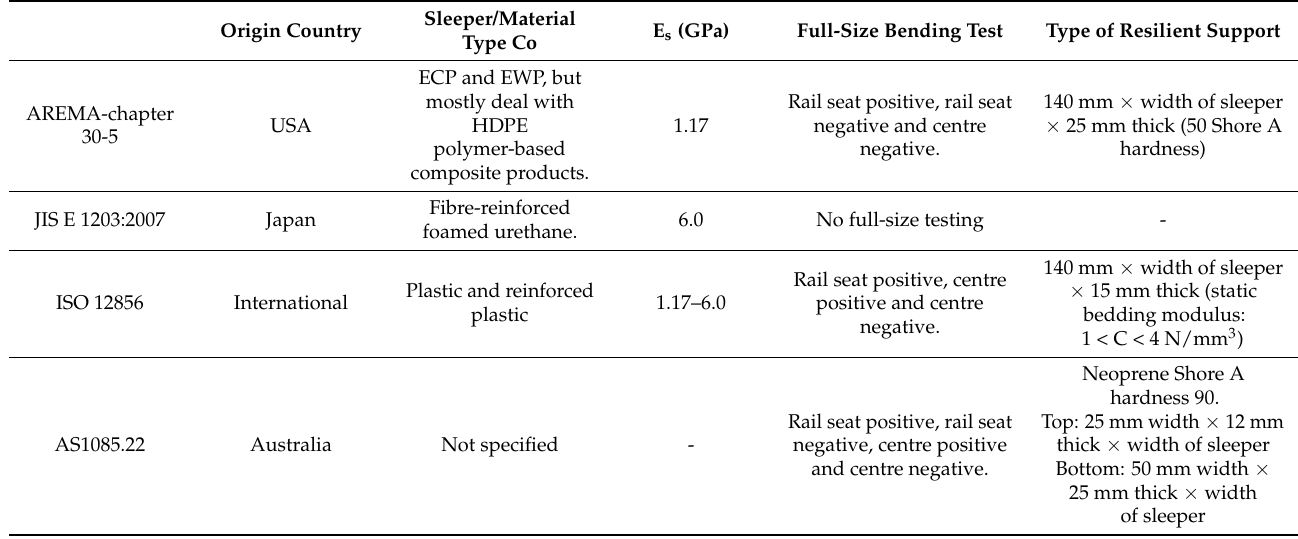
Table 1. Comparison of different alternative sleeper